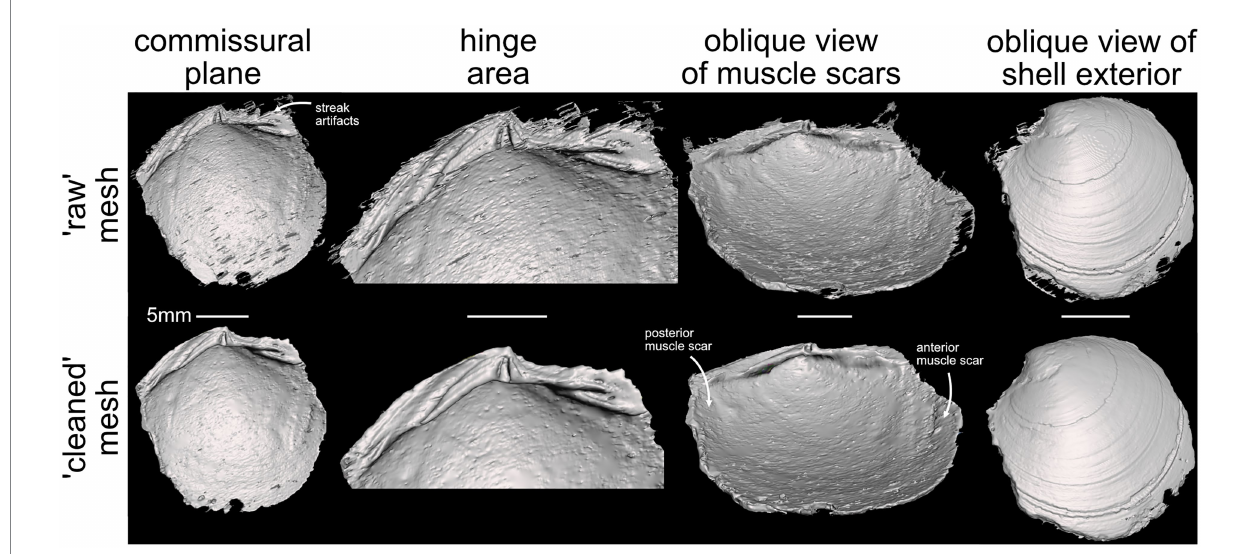
FIGURE 4 Taxonomically important views of the previously inaccessible interior features of Late Cretaceous (Early Maastrichtian) “Lucina” parvilineata , USNM PAL 20943. Top row shows the ‘raw’ mesh surface directly produced by deep learning segmentation after round 4 of training in Figure 3. Bottom row shows the final mesh surface after removal of streak artifacts and manual cleaning of noisy surface data where the model struggled to segment the shell from its surrounding matrix. Considerable care should be taken at this step so as not to erode any genuine, biological features.